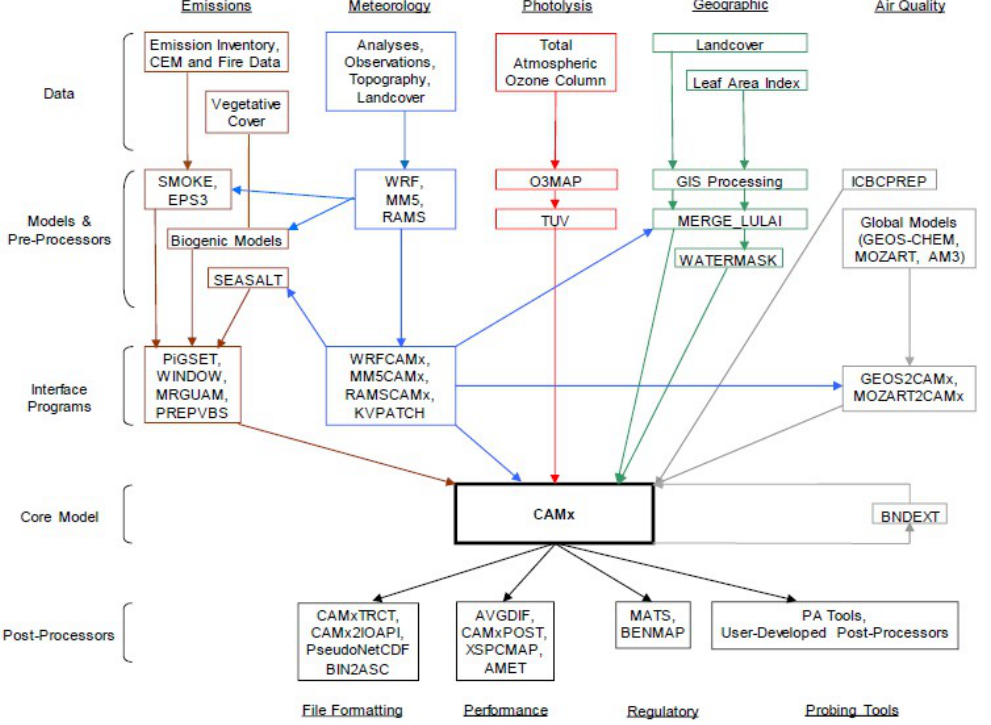
Figure 2. Schematic diagram of the Comprehensive Air Quality Model with eXtensions (CAMx) modelling